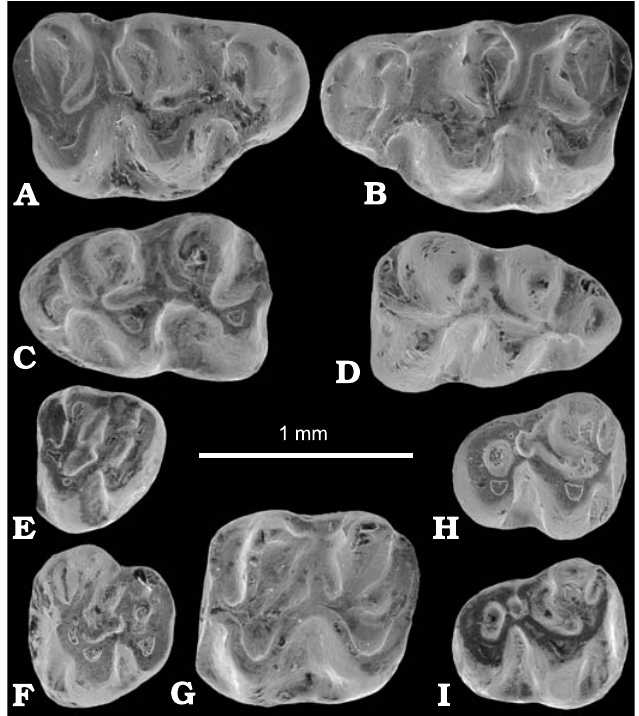
Fig. 2. Cricetodontid rodent Megacricetodon hellenicus sp. nov. from the Aliveri South quarry, Greece (MN4, Early Miocene). A . IAUU AL - -S-1112, M1 right. B . IAUU AL-S-1114, M1 left. C . IAUU AL-S-1118, M3 left. D . IAUU AL-S-1119, M3 left. E . IAUU AL-S-1122, m1 left. F . IAUU AL-S-1124, m1 right. G . IAUU AL-S-1115, M2 left. H . IAUU AL-S-1128, m3 right. I . IAUU AL-S-1129, m3